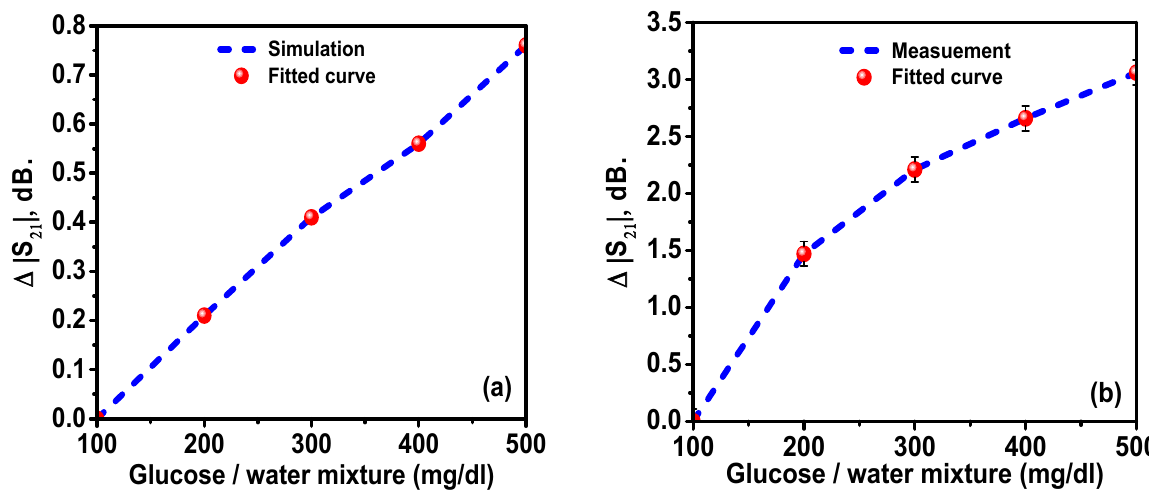
Figure 15. Transmission level variation, ∆ | S 21 | , in dB as a function of the glucose concentration in water: ( a ) simulated and ( b ) measured.